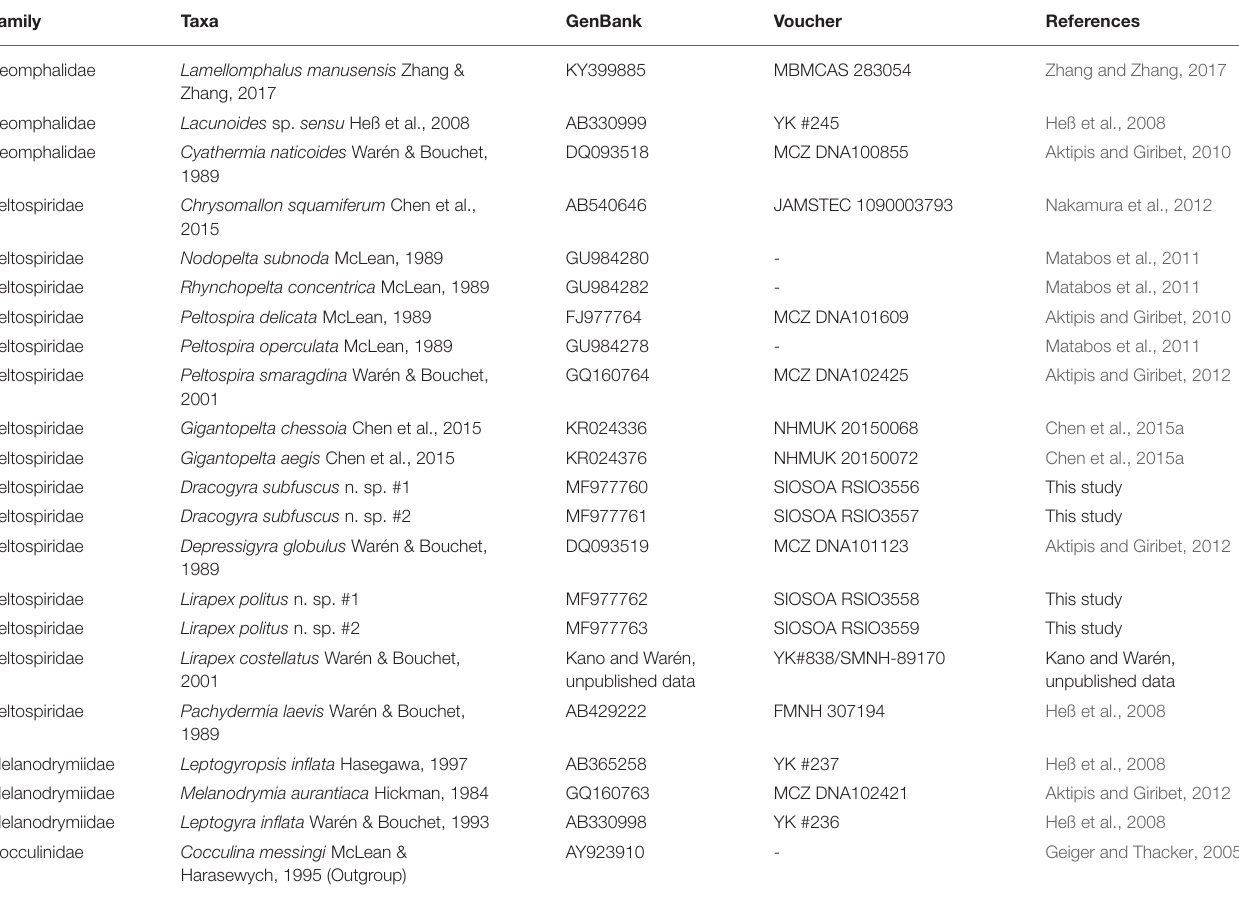
TABLE 1 | List of taxa used for phylogenetic analysis using COI gene, with GenBank accession number, voucher number (where available), and original references shown.